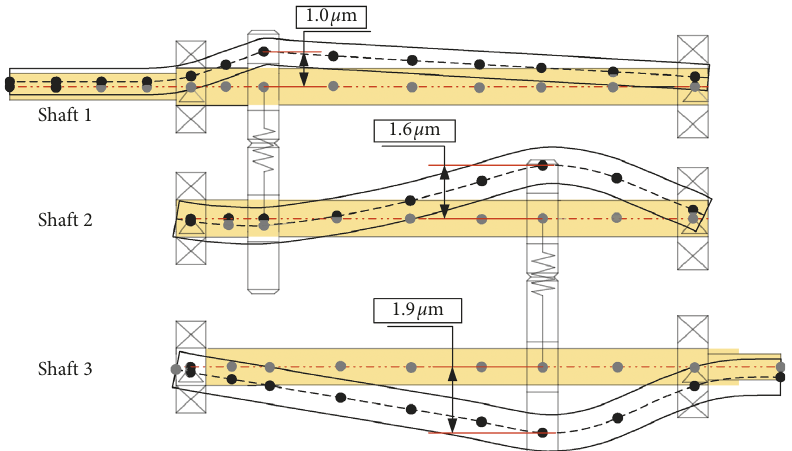
Figure 9: Schematic before and after deformation of transmission shaft.